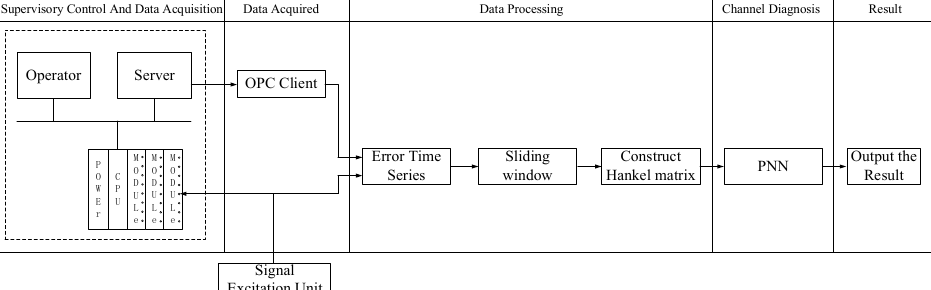
Figure 4. The structure of proposed approach.